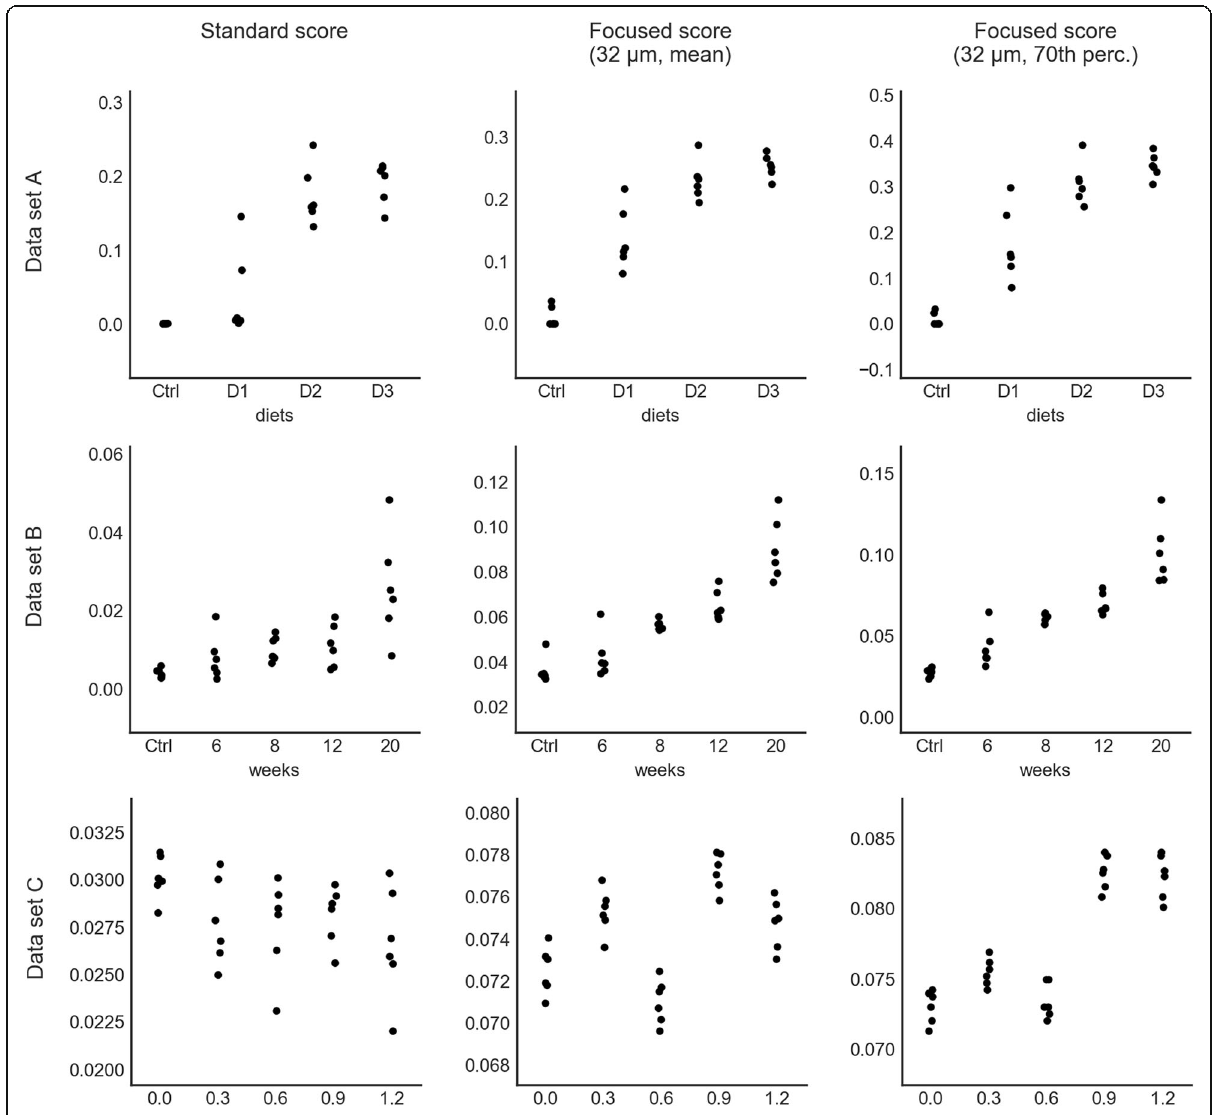
Fig. 5 Score values. Distributions of score values obtained on data set A, B, and C. The horizontal axes give the groups of the respective data set, the vertical axes give the respective score values. Every dot represents one image. For better readability, the dots where randomly displaced by small amounts in horizontal